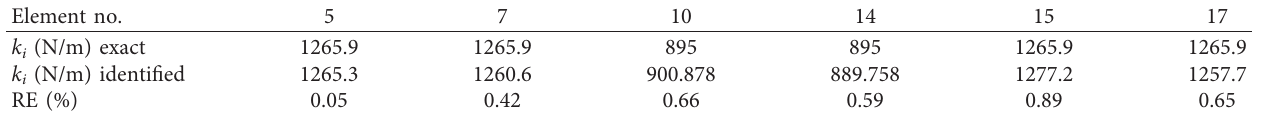
Table 1: Comparison of the stiffness parameters of the identified truss elements. Element